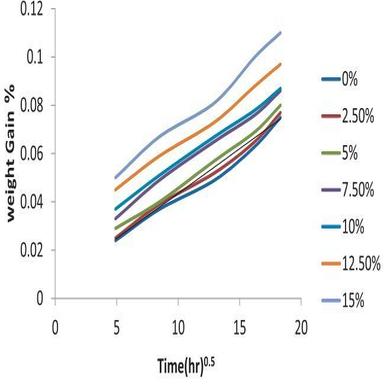
Gain in absorbance with square root of time for wool fiber samples.